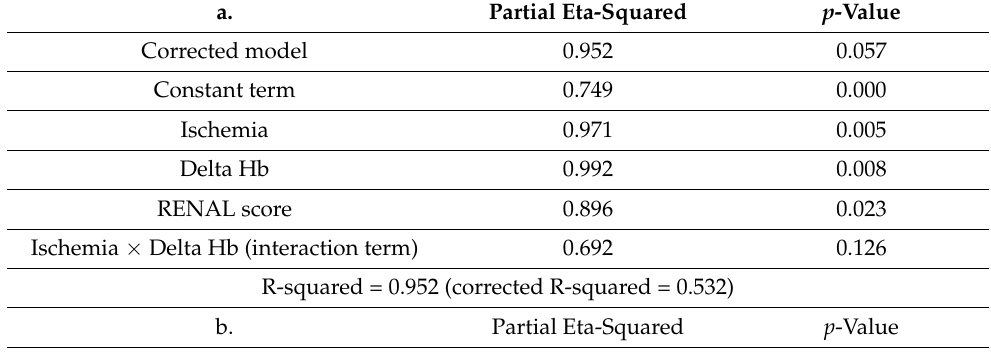
Table 2. Generalized linear model with delta creatinine (pre to post) as dependent variable; a. baseline model; b. model assessing the interaction between history of hypertension and blood